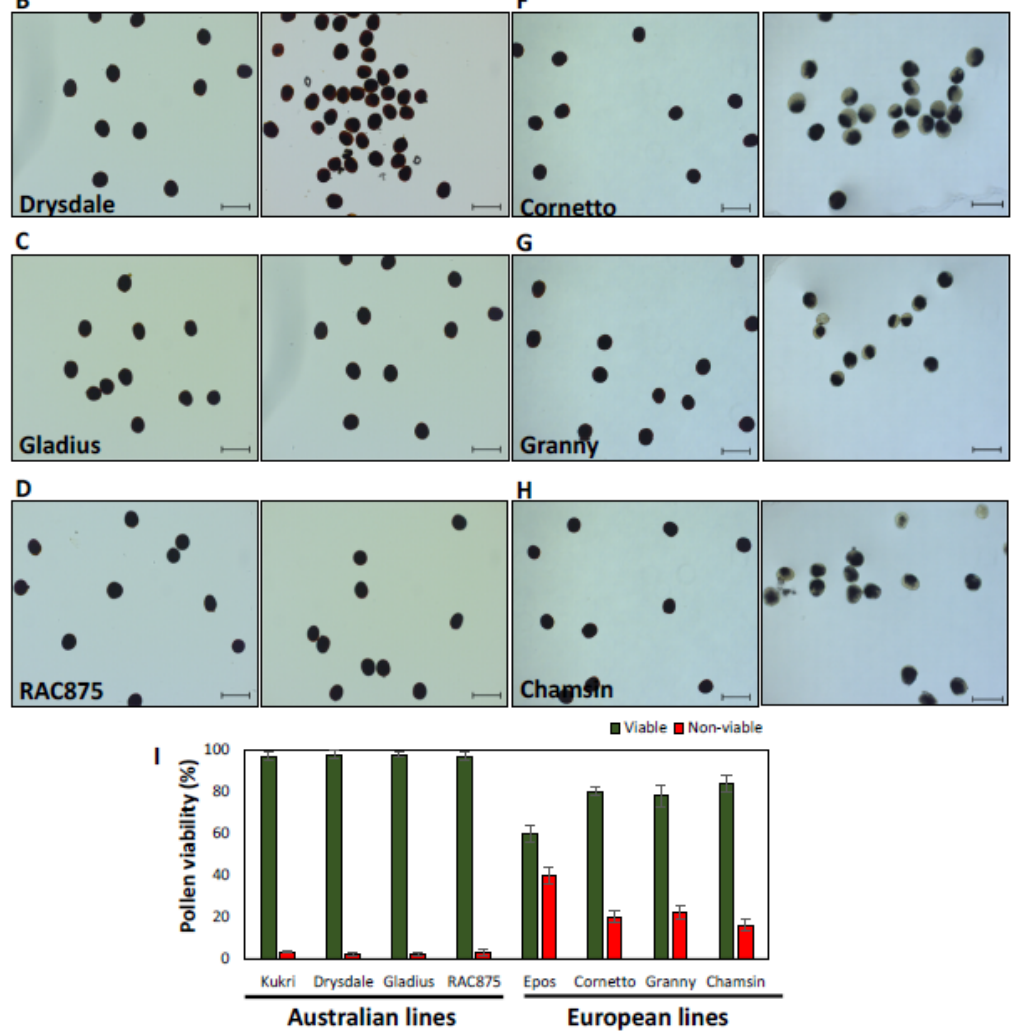
Figure 4. Pollen viability determined in Australian ( A – D ) and European ( E – H ) summer wheat varieties under non ‐ stress and moderate heat ‐ stress conditions. Pollen released from anthers were stained with lugol ‐ iodine (I2 ‐ IK). ( I ) Percentage of viable pollen compared between Australian and Europeans summer wheat varieties after exposure to moderate heat stress during pollen mitosis.